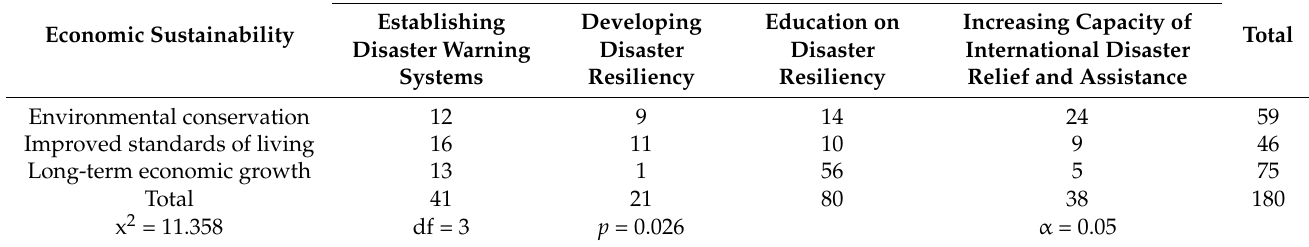
Table 4. Cross-tabulation of key focus areas of governance in developing disaster resiliency and economic sustainability.